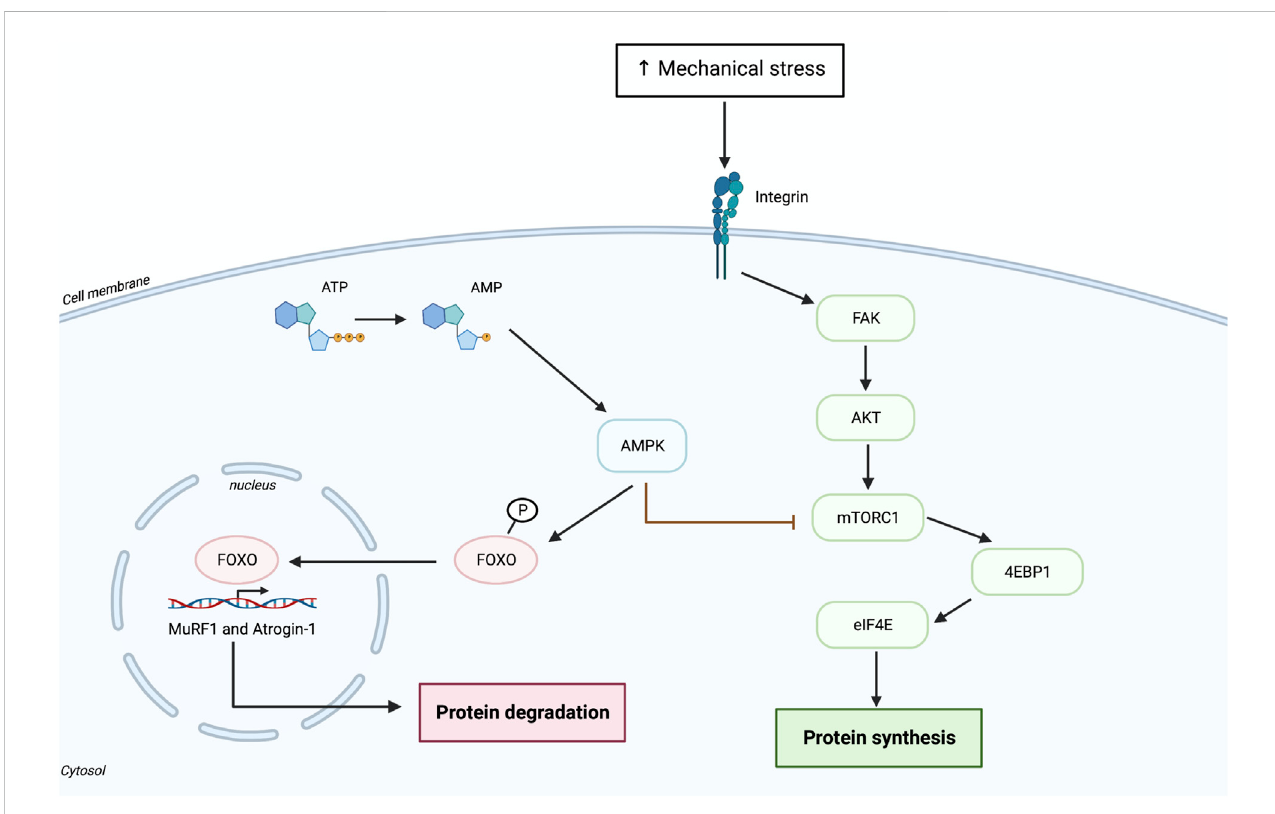
FIGURE 2 Activation of AMPK signaling pathway following aerobic